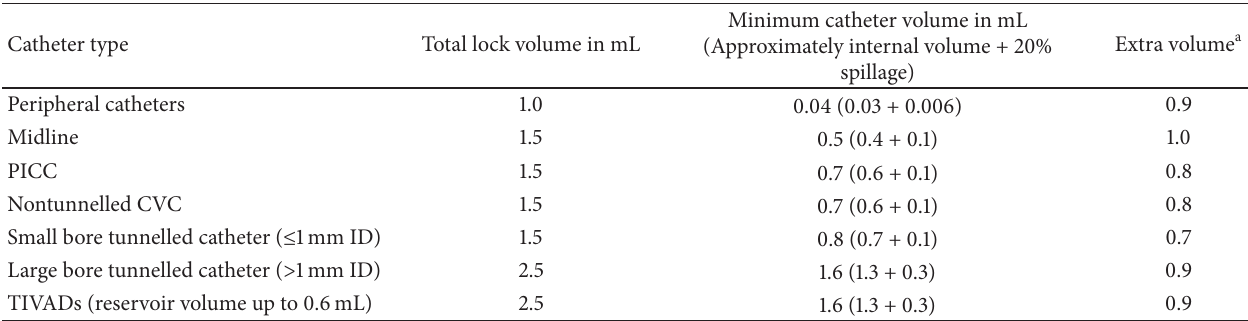
Table 4: Calculation of recommended locking volumes if lock does not cause adverse effects when systemically